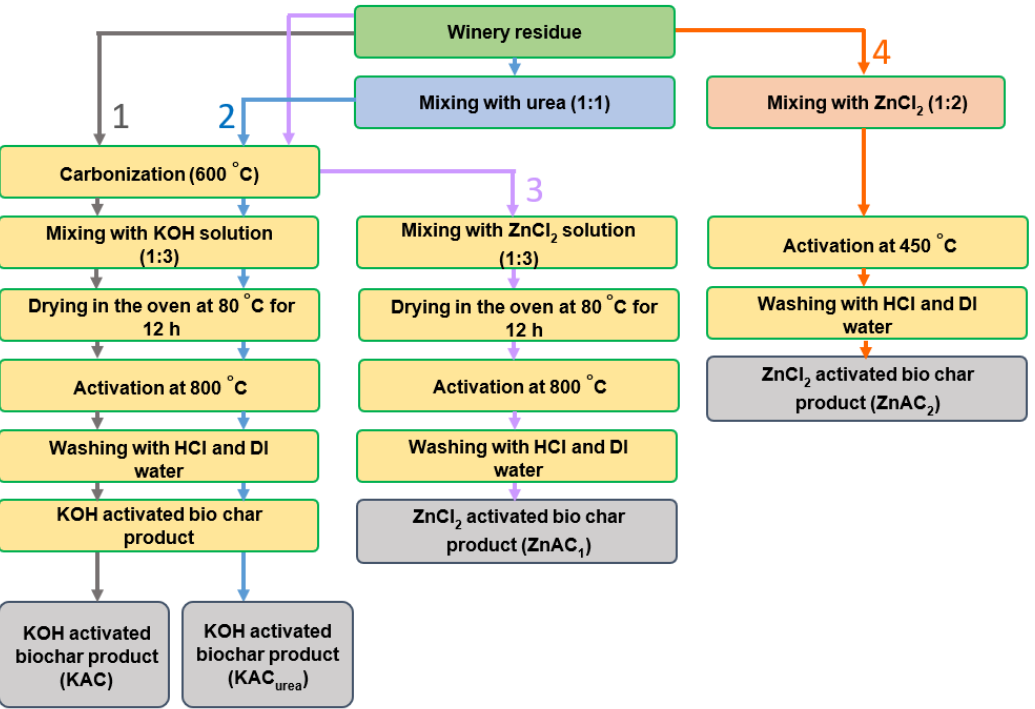
Figure 1. Flow diagram of the synthesis conditions followed in producing activated carbon (AC).